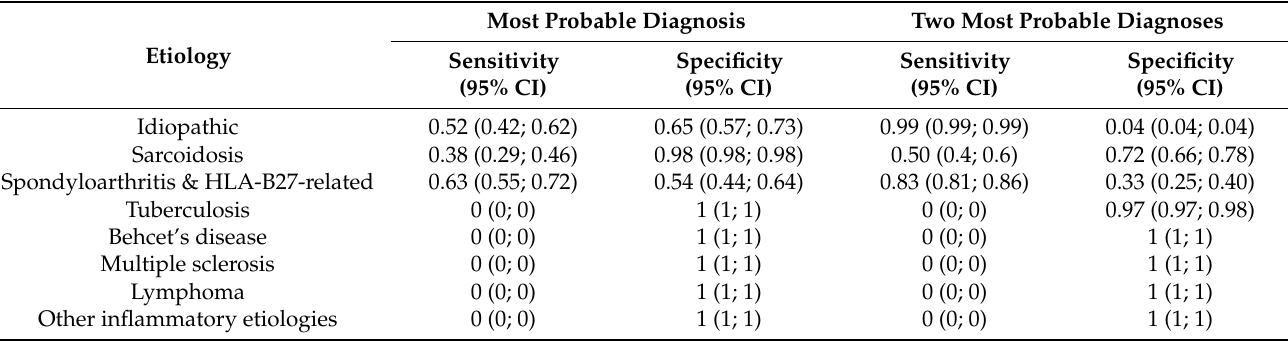
Table 3. Sensitivity and specificity of the Bayesian network to identify the uveitis etiology using the most probable diagnosis and the two most probable diagnoses: estimates in the test